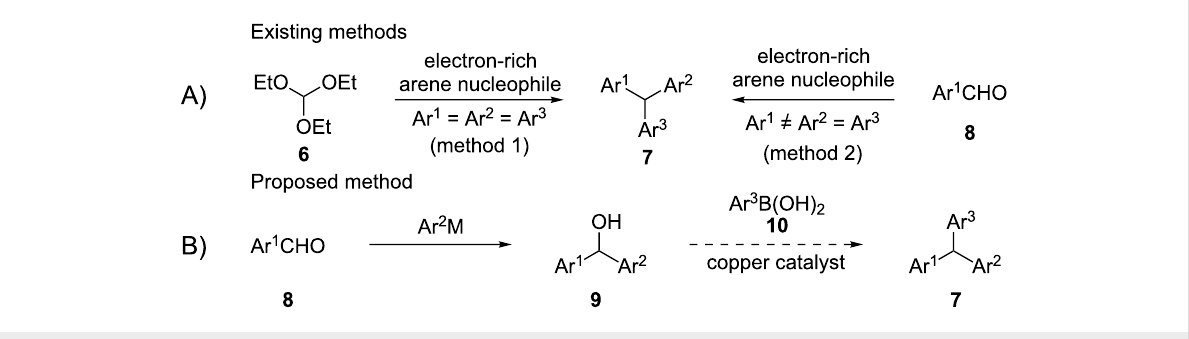
Scheme 1: General methods and proposed method for the synthesis of triarylmethanes.